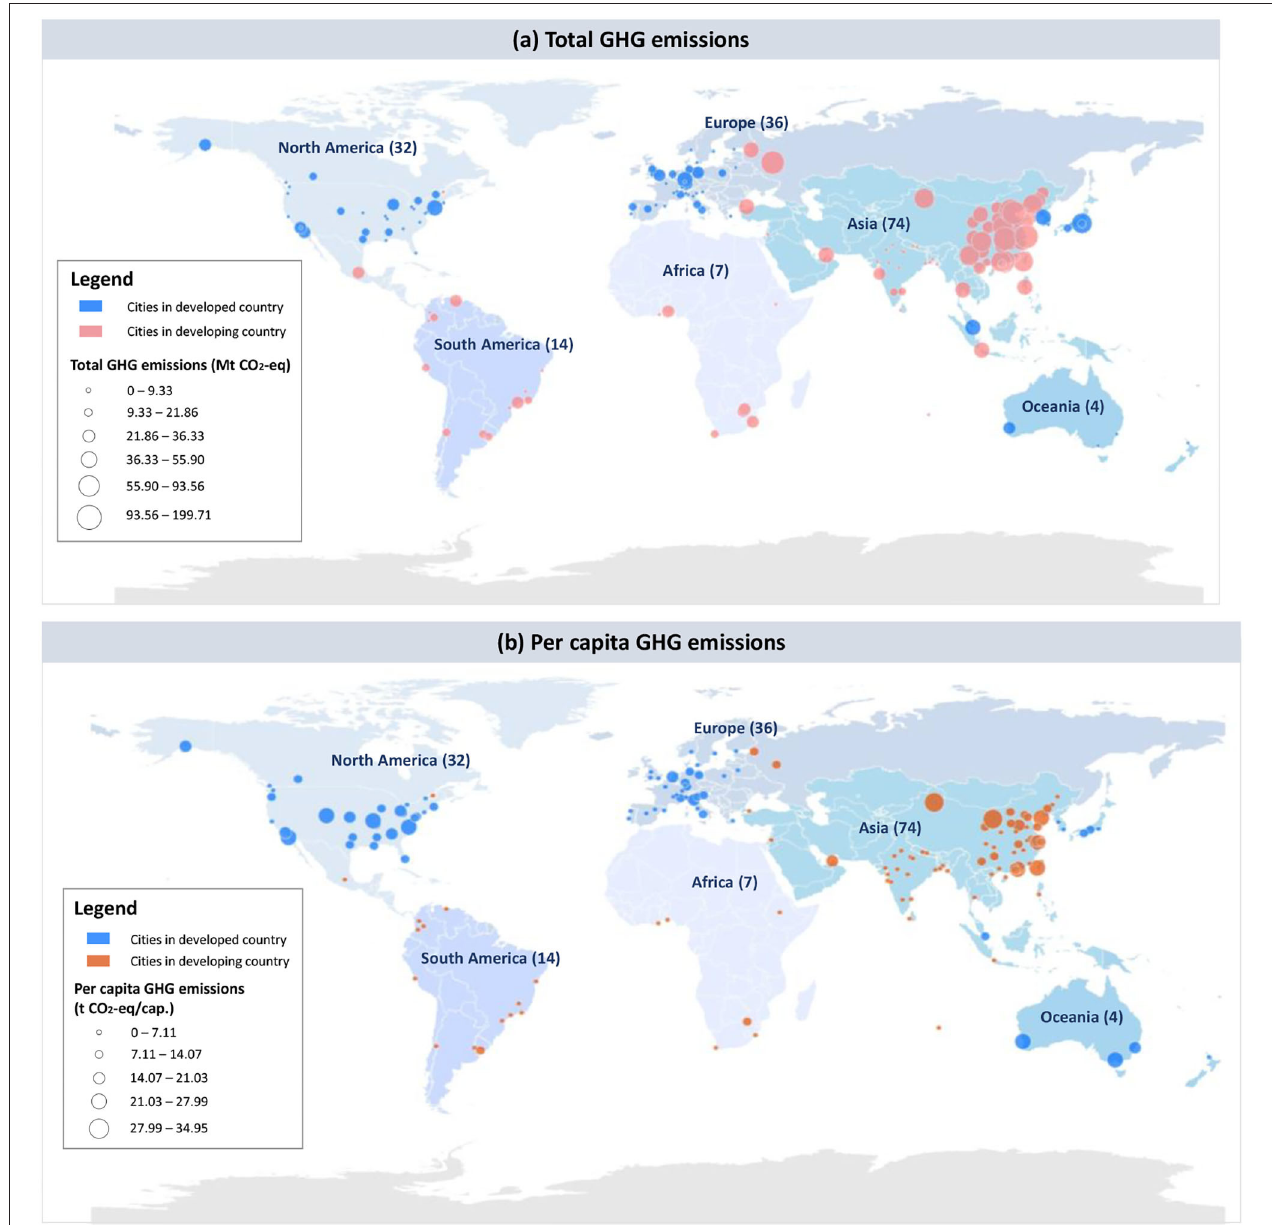
FIGURE 1 | The (a) total GHG emissions and (b) per capita GHG emissions of 167 cities. Most recent data of cities are shown, which could be in different years (2005–2016), depending on the data